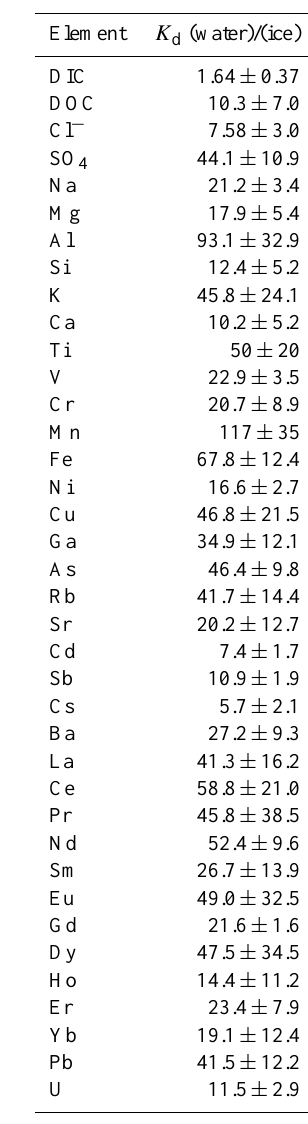
Table 2. Distribution coefficient of soluble components between the lake water and the ice (average of three samples). The lower part of the ice column, formed in quasi-equilibrium with the remaining bottom water, was used for this